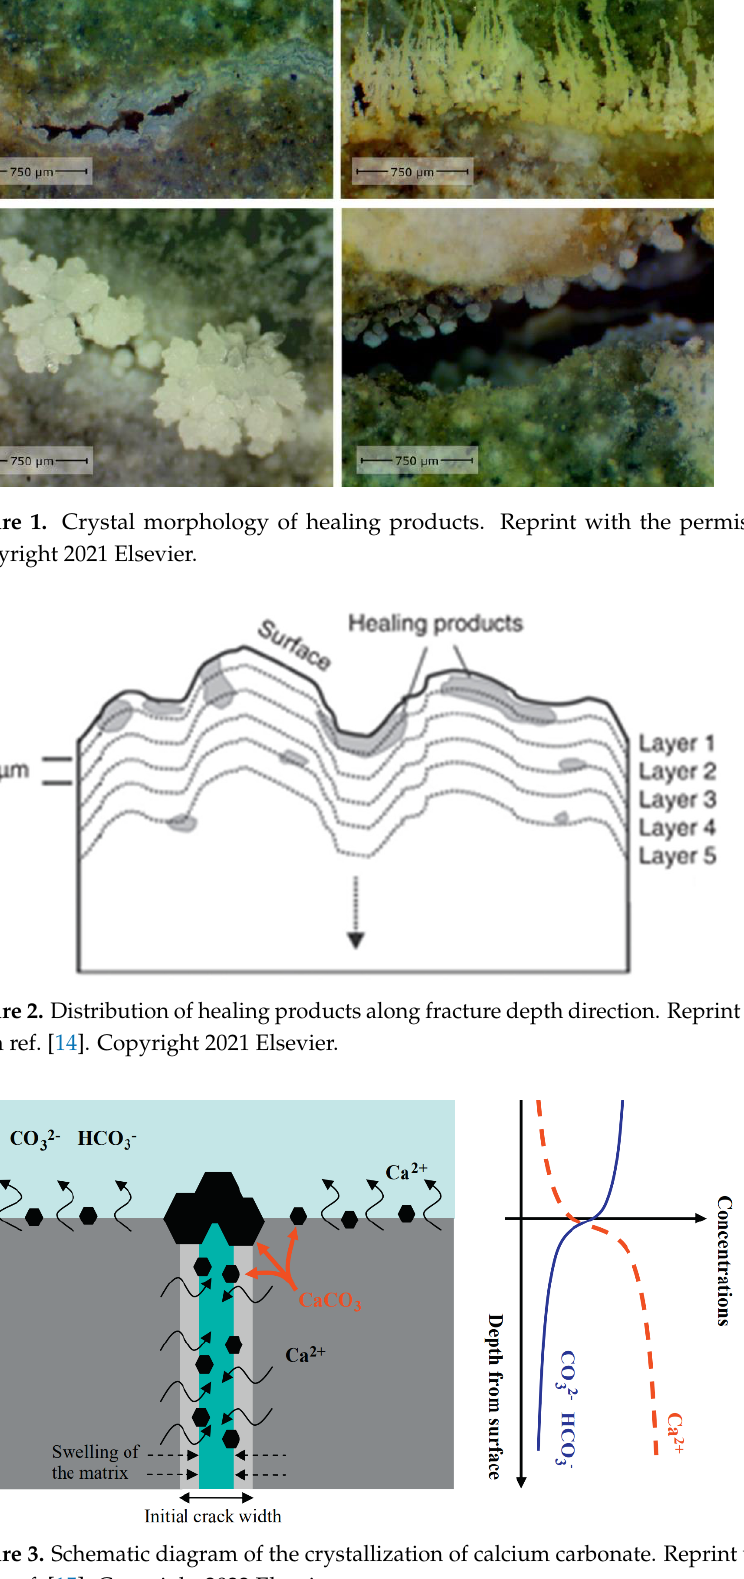
Figure 3. Schematic diagram of the crystallization of calcium carbonate. Reprint with the permission from ref. [15]. Copyright 2022 Elsevier.